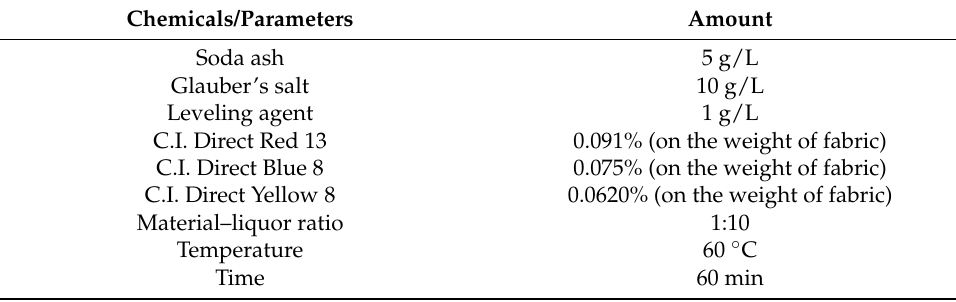
Table 4. Recipe for the direct dyeing of cotton